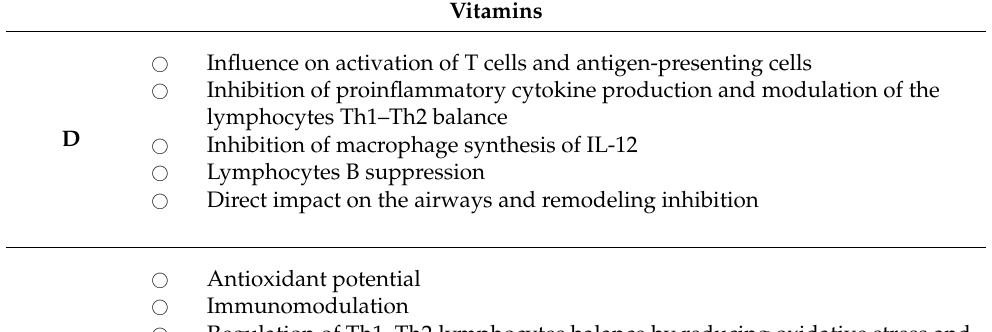
Table 1. Proposed mechanism of action of vitamins in asthma primary prevention.